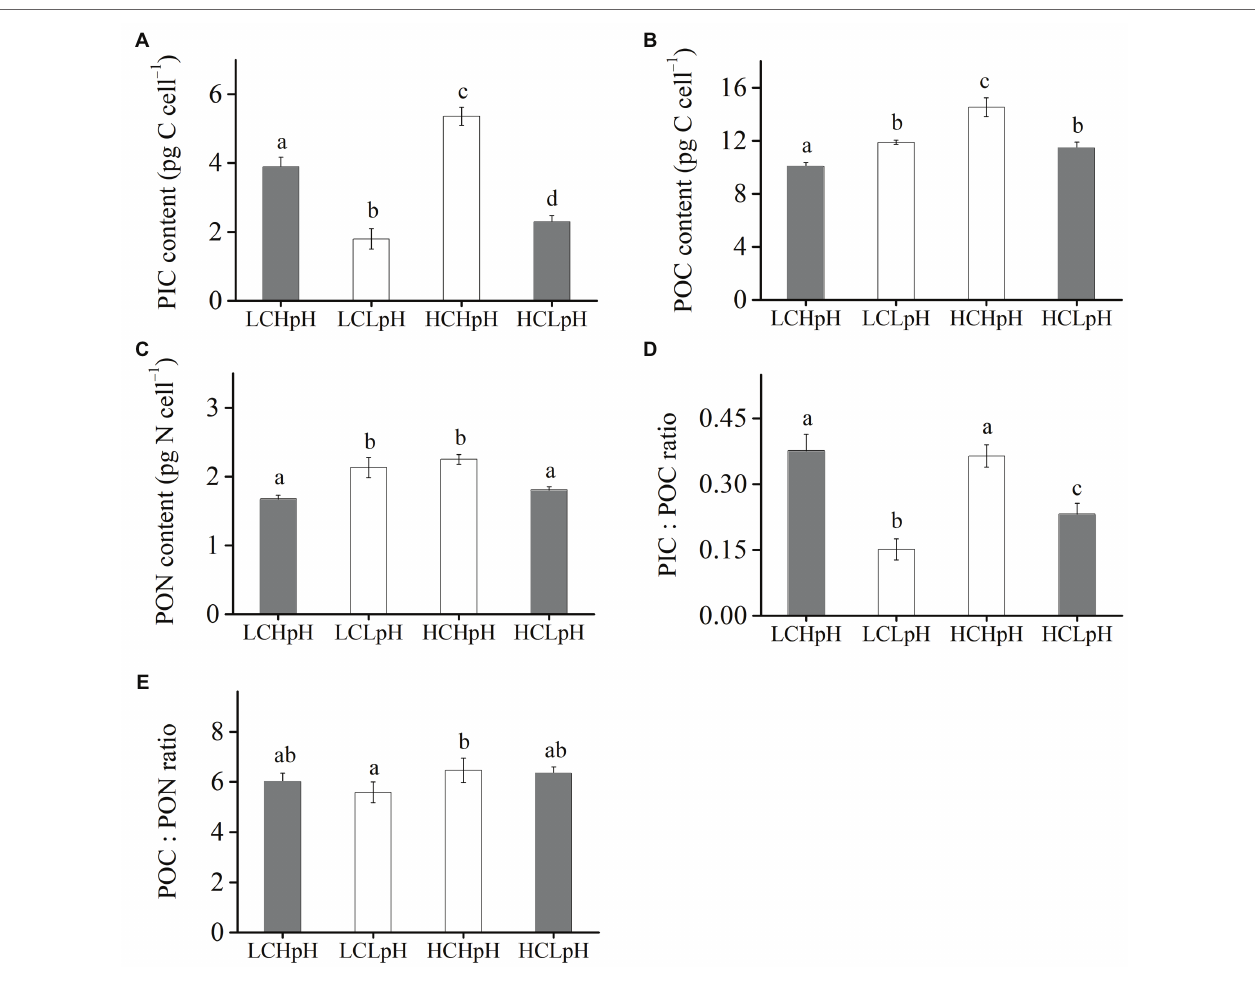
percentage of POC allocated to protein ( p = 0.08; Figure 5A , gray), significantly increased the percentage of POC allocated to carbohydrate by 21.52% ( Figure 5B , gray) and did not significantly affect the percentage of PON allocated to protein ( p = 0.82; Figure 5E , gray). Under high or low pH treatments, elevated DIC concentrations protein (Protein–C: POC; p = 0.07 at high pH; p = 0.88 at